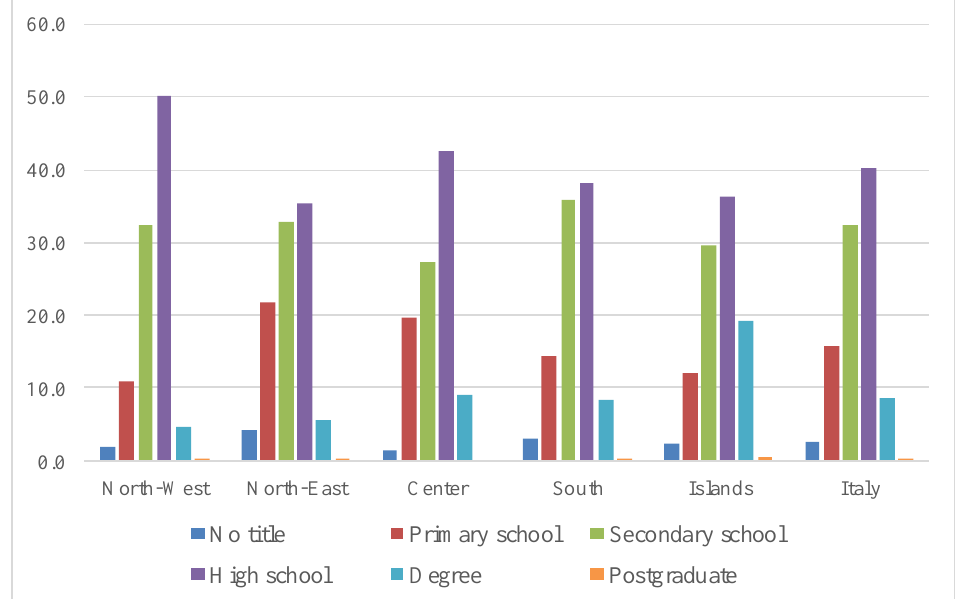
Figure 6. Percentage distribution of small farms by qualification of tenants and by district. Source: Our elaboration on FADN data, 2018 – 2020.